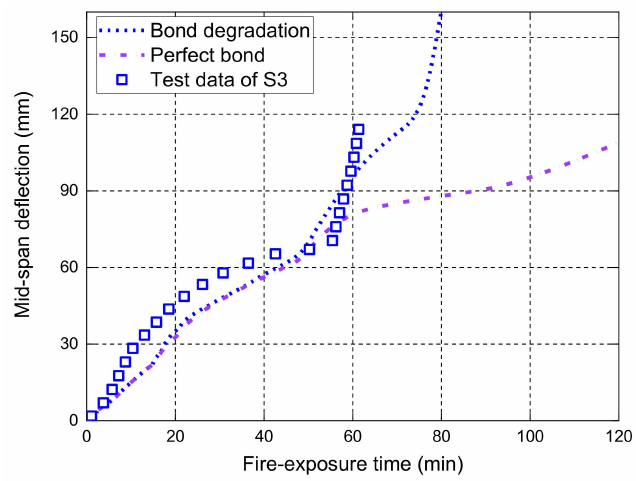
Figure 13. Effect of bond degradation on the midspan deflection responses of